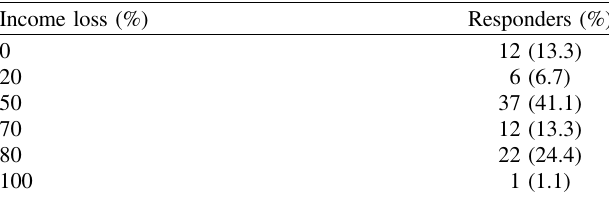
Table 2. Effects of COVID-19 on spine surgeons ’ monthly income.